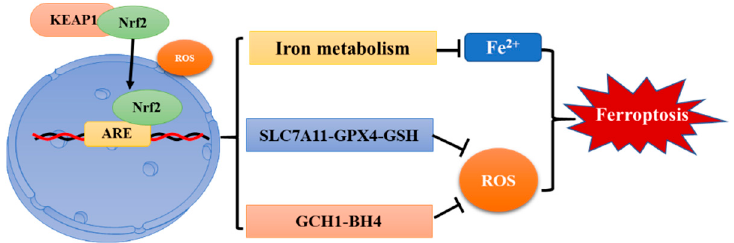
Figure 3. Regulation of ferroptosis by Nrf-2.